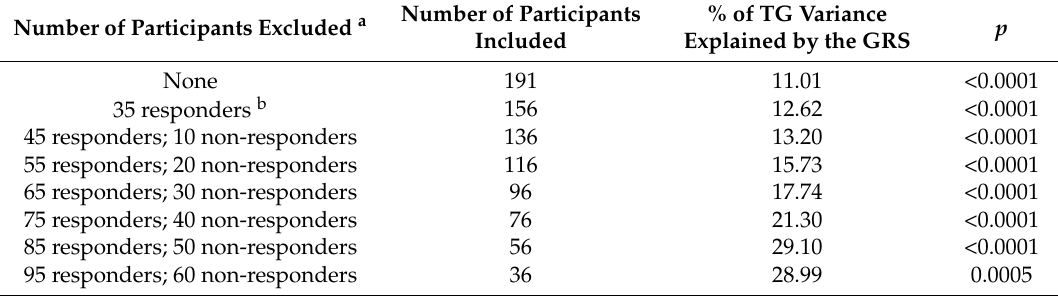
Table 3. Differences in the triglyceride (TG) variation explained by the 5-SNPs GRS in the general linear model with participants retrenched.